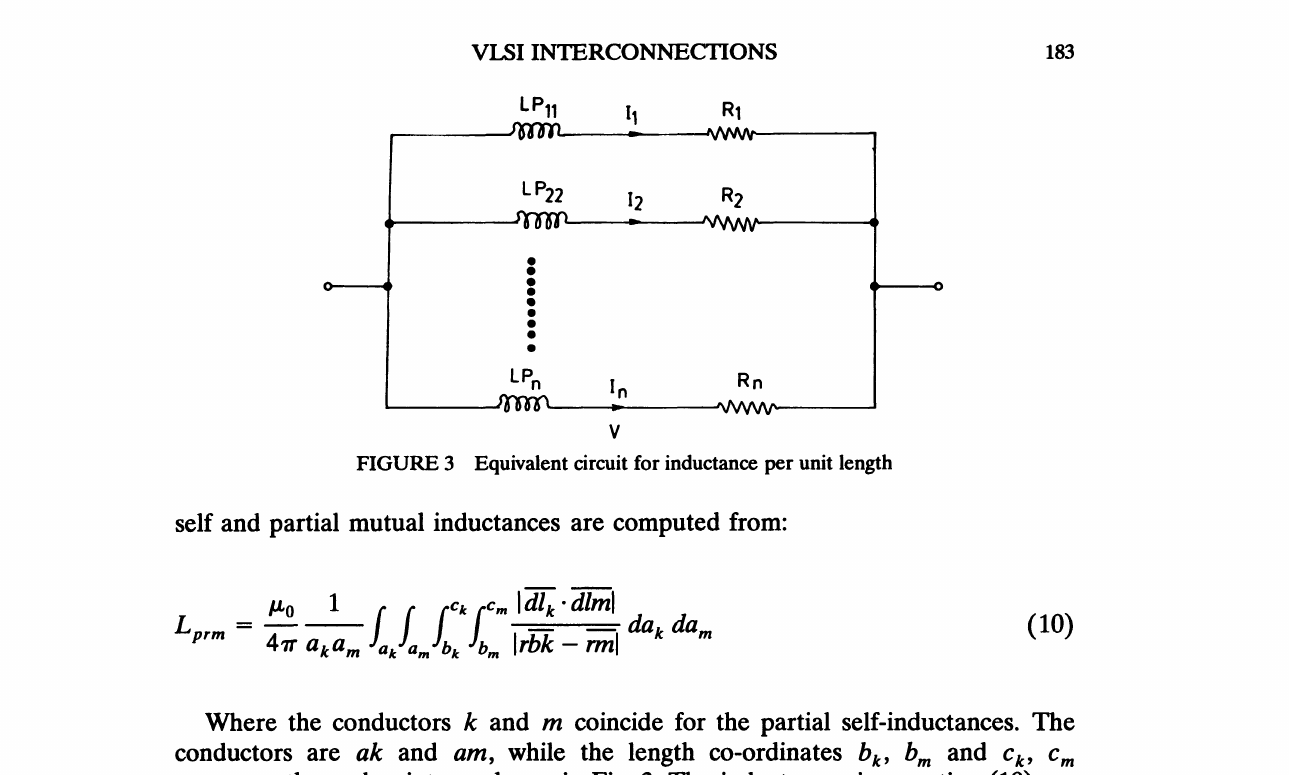
Equivalent circuit for inductance per unit length FIGURE